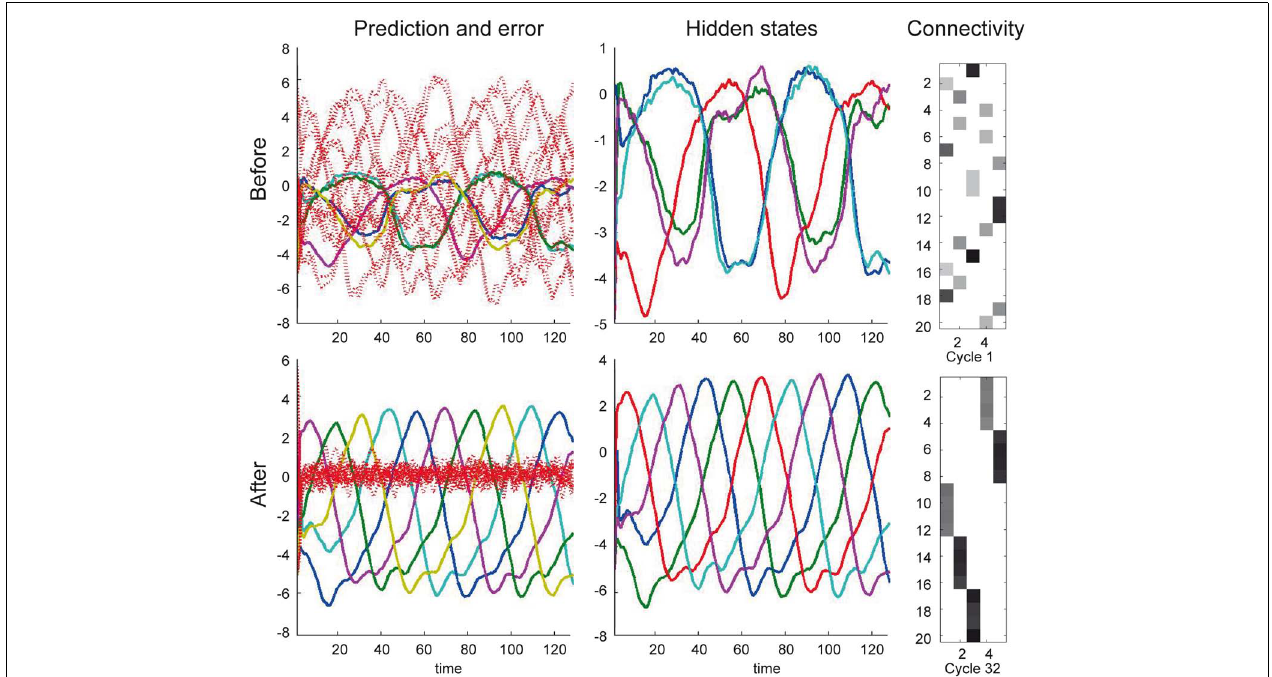
Lotka–Volterra dynamics and the sensory input.The right panel indicates the synaptic configuration (as expected log-precisions). (Bottom) Same representation as top panels but after synaptic reconfiguration is complete.The dendrite samples the presynaptic neurons such (right panel) that the expected Lotka–Volterra dynamics are supported by the input. Note that the prediction error (left panel) has a log-precision of about two (which is what we used when simulating the